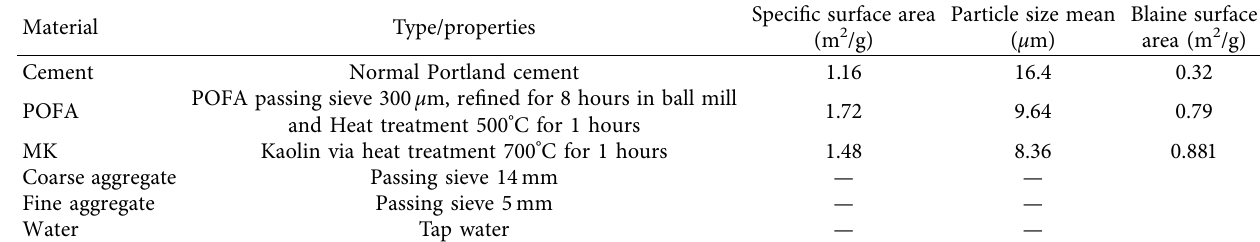
Table 1: Properties of material.